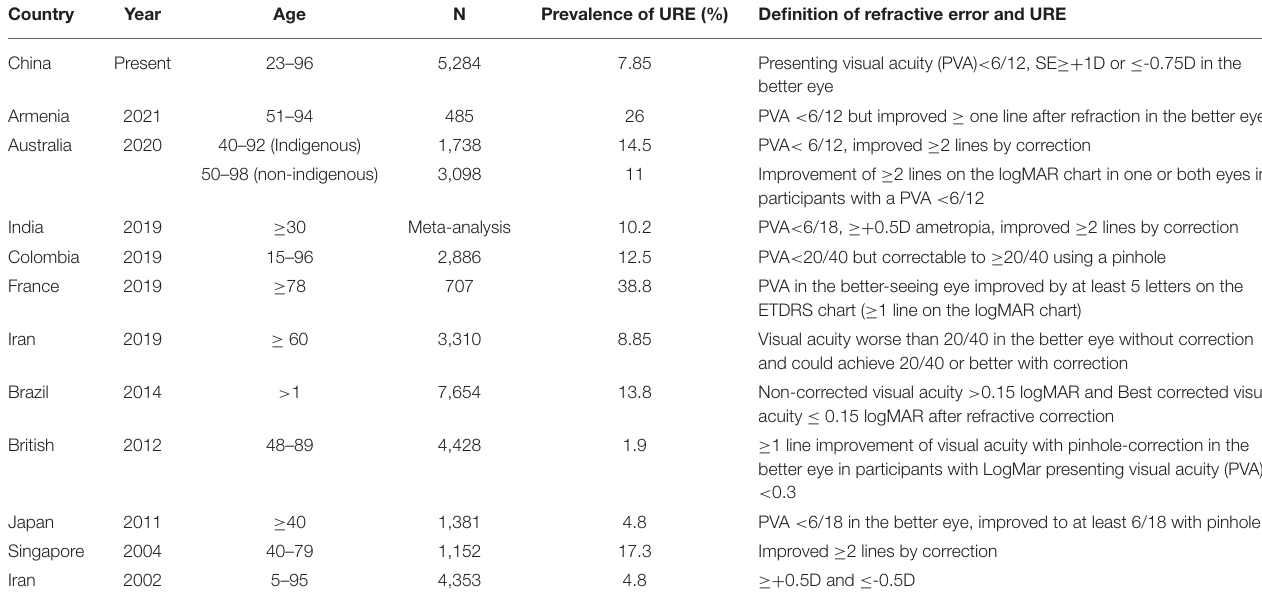
TABLE 5 | Prevalence of URE among the different studies.